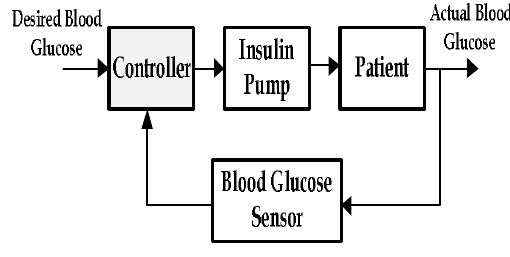
Fig. 1. Block diagram of closed loop insulin regulation system